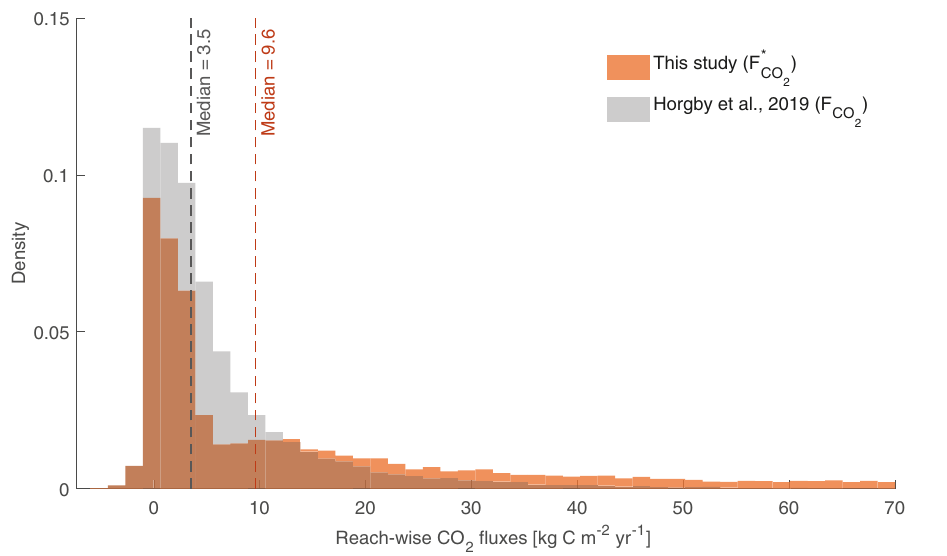
Fig. 5 | Effect of steps on CO 2 emissions from Swiss mountain streams. Fre- quencydistributionofreach-wiseCO 2 fl uxesestimatedbyHorgbyetal. 8 , F CO histograms),and thecorresponding frequencydistribution ofthe fl uxes estimated by taking into account the local emissions generated by steps, F * CO